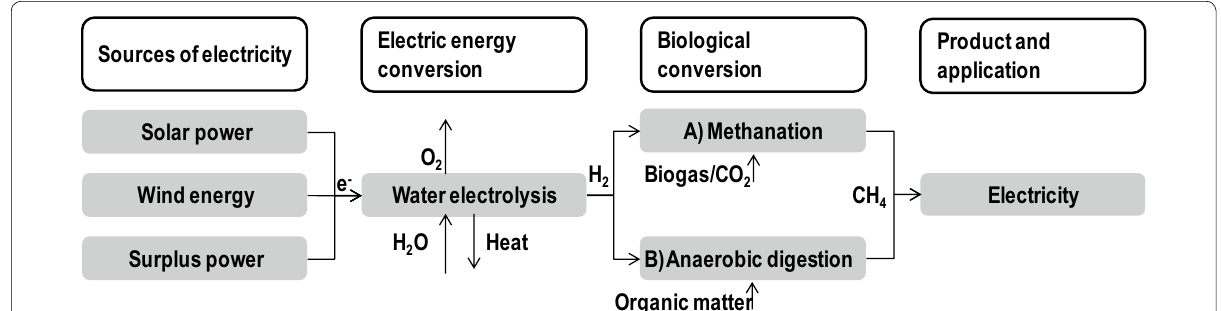
Fig. 5 Increasing methane yield by hydrogen addition. H 2 is produced via water electrolyses and (A) fed into the second reactor for the conversion of CO 2 into methane, or (B) feed directly to the anaerobic digester for in situ methane